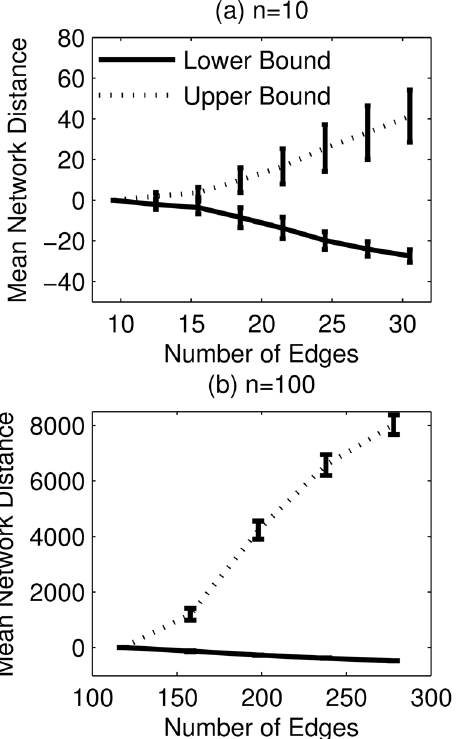
Figure 8. Ensemble inference of S.cerevisieae GRN from error- free (cid:2) GG 6 0 and the 100 most informative (cid:2) GG f i g ’s based on the number of testable edges. The plot shows the network distances of the lower and upper bounds from G 6 0 as a function of the number of (cid:2) GG (cid:2) GG f i g ’s. The incorporation of f i g ’s and G f i g ’s was performed sequentially in decreasing number of testable edges.